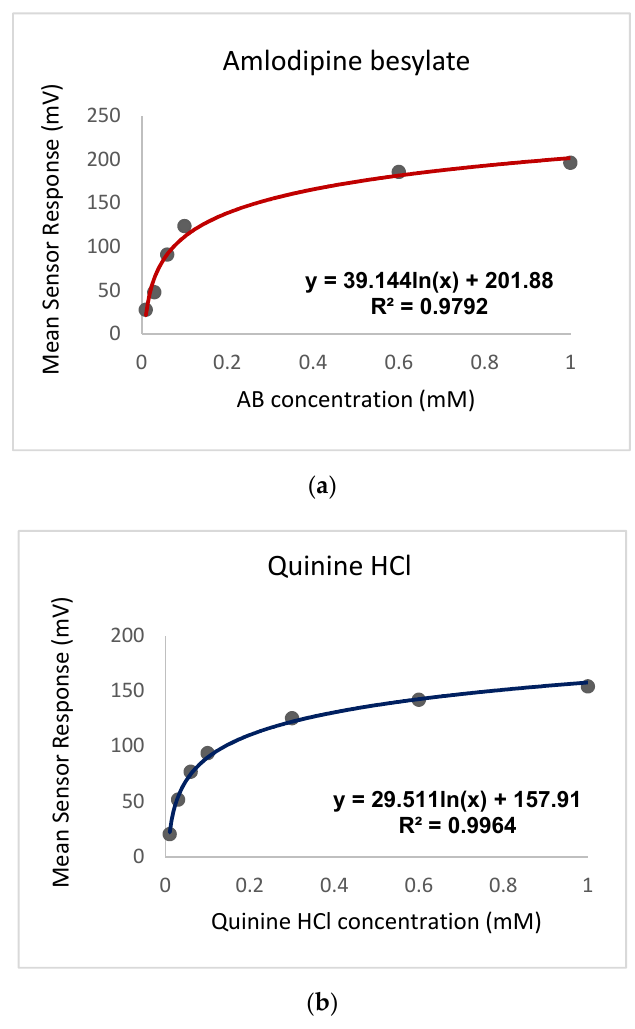
Figure 4. AC0 logarithmic trend-line sensor response curve showing initial taste for ( a ) amlodipine besylate and ( b ) quinine HCl dihydrate.